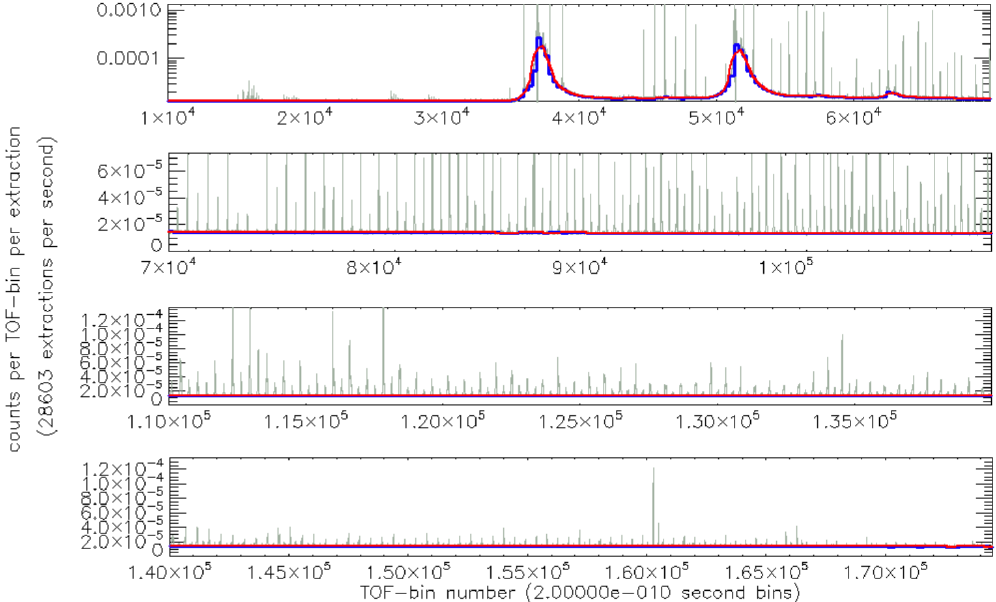
Figure 3. An example SumSpectrum zoomed in to the baseline (grey data). The blue stepwise data show the baseline values of individual 90ns segments (see text for details). The baseline is obtained by smoothing over these individual baseline values (red